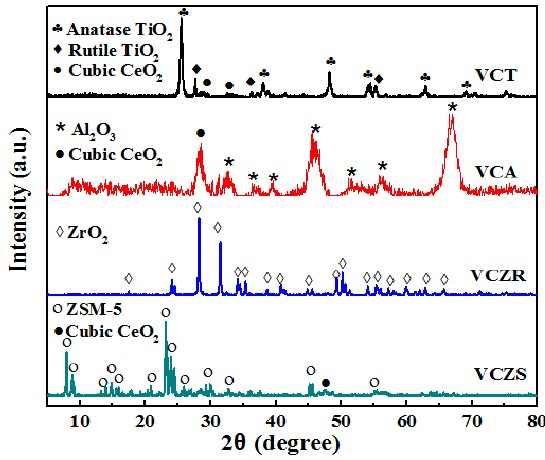
Figure 1. X-ray di ff raction patterns of di ff erent samples. Figure 1. X-ray diffraction patterns of different samples.